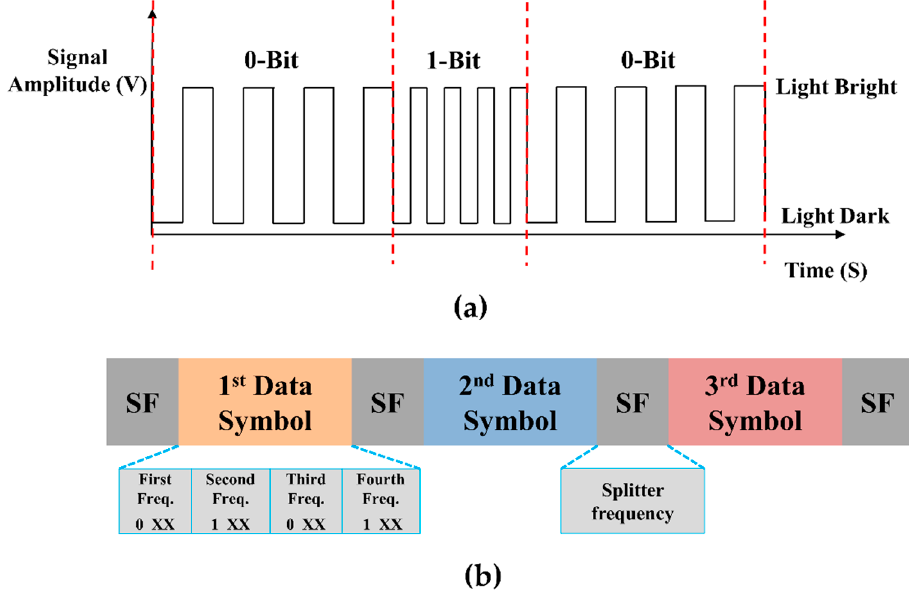
Figure 2. ( a ) FSOOK modulation signal; ( b ) the packet format of modulation light.